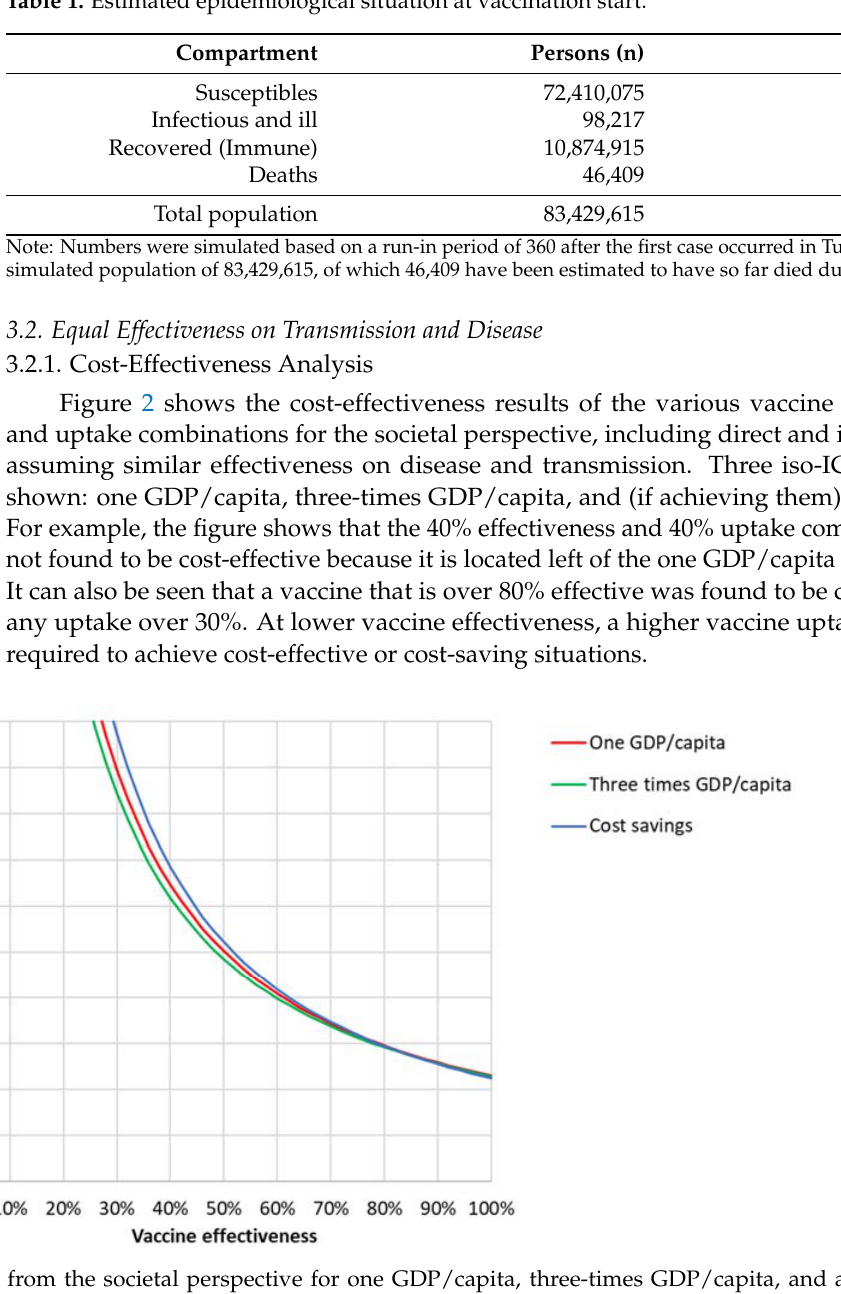
Table 1. Estimated epidemiological situation at vaccination start.